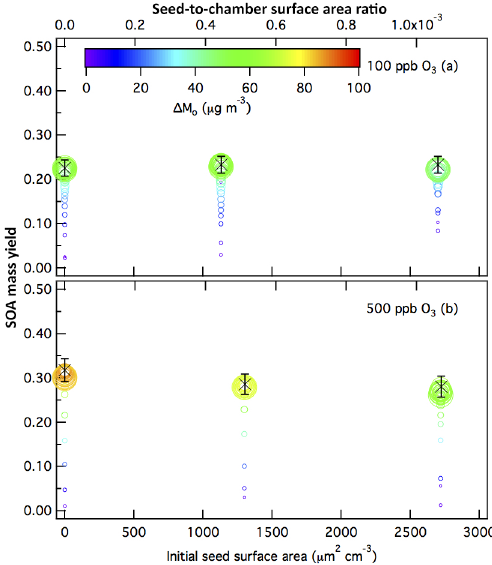
Figure 3. Time-dependent SOA growth curves for α -pinene ozonol- ysis. Panels (a, b) show 10min averaged results from the 100 and 500ppb O 3 experiments, respectively. Only SOA growth data up to the point of SOA peak growth are shown.